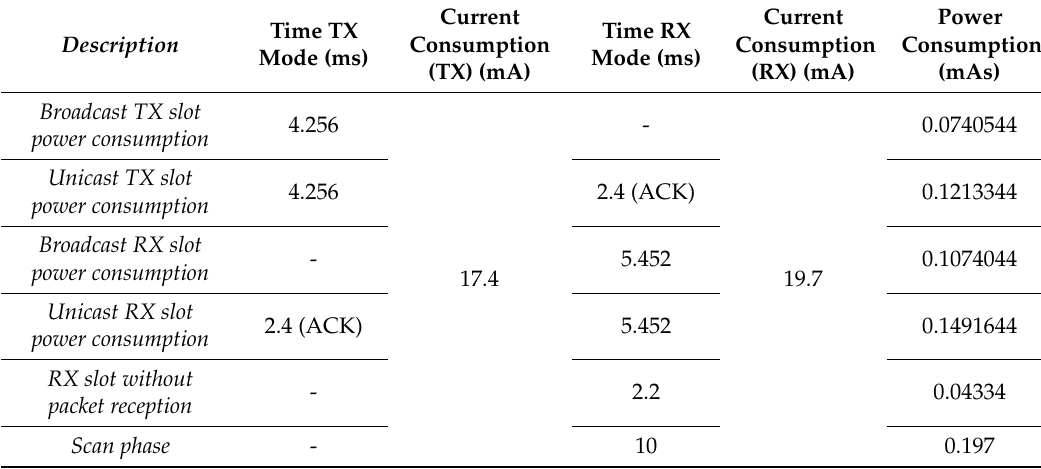
Table 3. The power consumption for the different slot types.